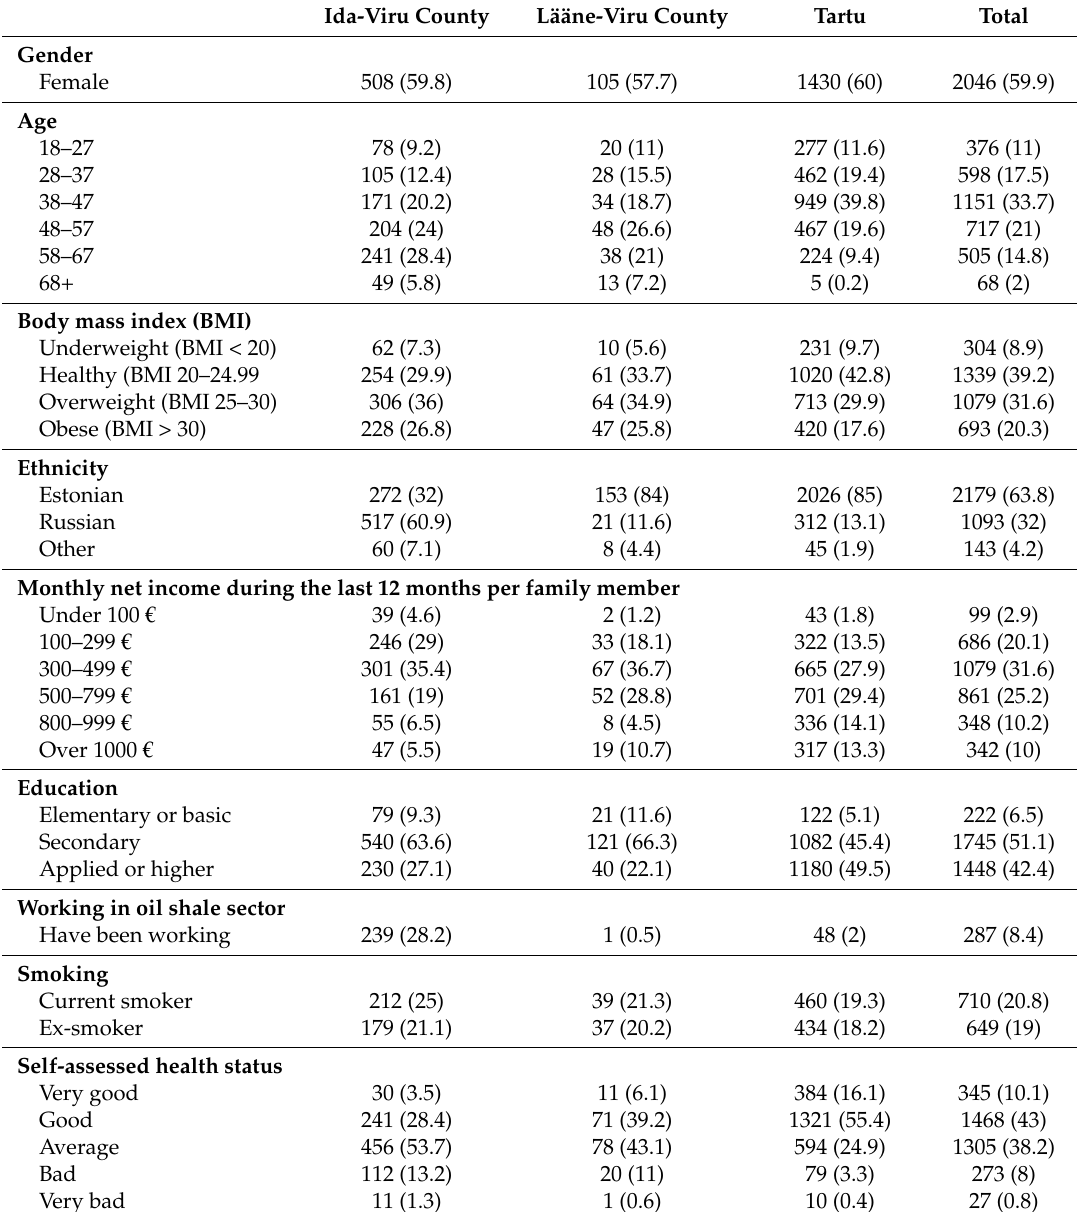
Table 1. Socio-demographic characteristics of the respondents, n